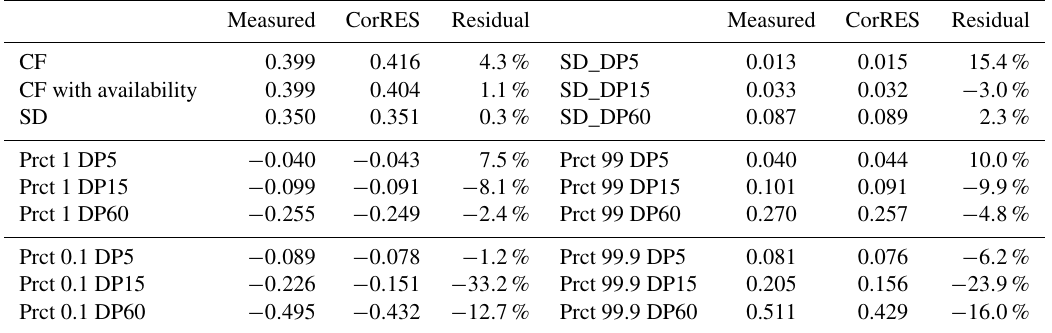
Table 3. BE2018 residuals (prediction error) in capacity factor (CF), standard deviation of standardized power (SD), and standard deviation of 5, 15, and 60min power fluctuations (DP5, DP15, DP60).